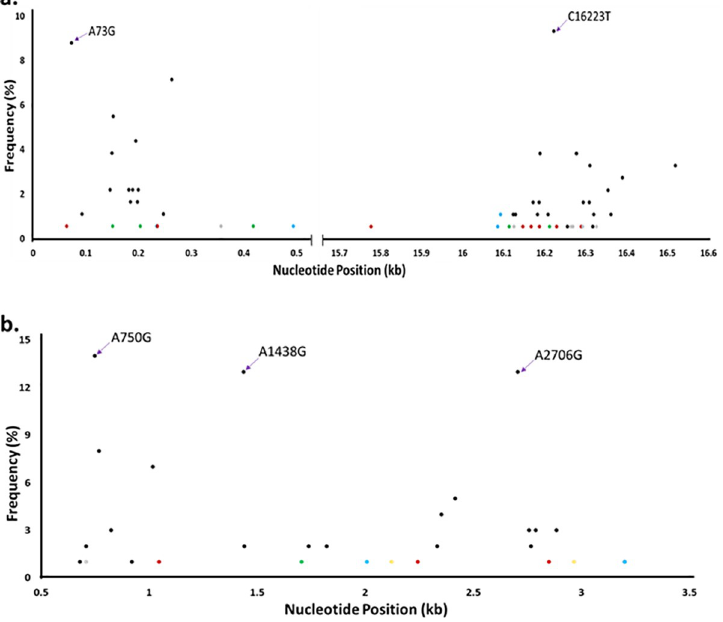
Fig 1. Point mutations at the control regions and rRNA genes of the mtDNA of patients presenting with male infertility. The point mutations detected in only one abnormospermia are represented as oligozoospermia (brown), asthenoteratozoospermia (green), oligoasthenozoospermia (grey) and oligoasthenoteratozoospermia (blue). (a) Point mutations at the control regions. The brown dots are C64T, T236C, G15777A, C16148T, C16168T, C16188G, A16230G and C16290T. The green dots are C151T, T204C, C418T, C16114A and G16213A. The grey dots are A357G, T16126C, C16264T, C16270T, A16293G and C16327T. The blue dots are A235G, C494T, T16086C and T16093C. A73G and C16223T (purple arrows) were the most common mutations in the control region. The total mutations at the control region = 182. (b) Point mutations at the rRNA genes. The brown dots are C1048T, A2245C and A2851G. The green dot is C1706T. The grey dot is T710C. The blue dots are T2010C and T3202C. The yellow dots are A2124G and A2968G. A750G, A1438G and A2706G (purple arrows) were the most common mutations. The total mutations at the rRNAa genes =